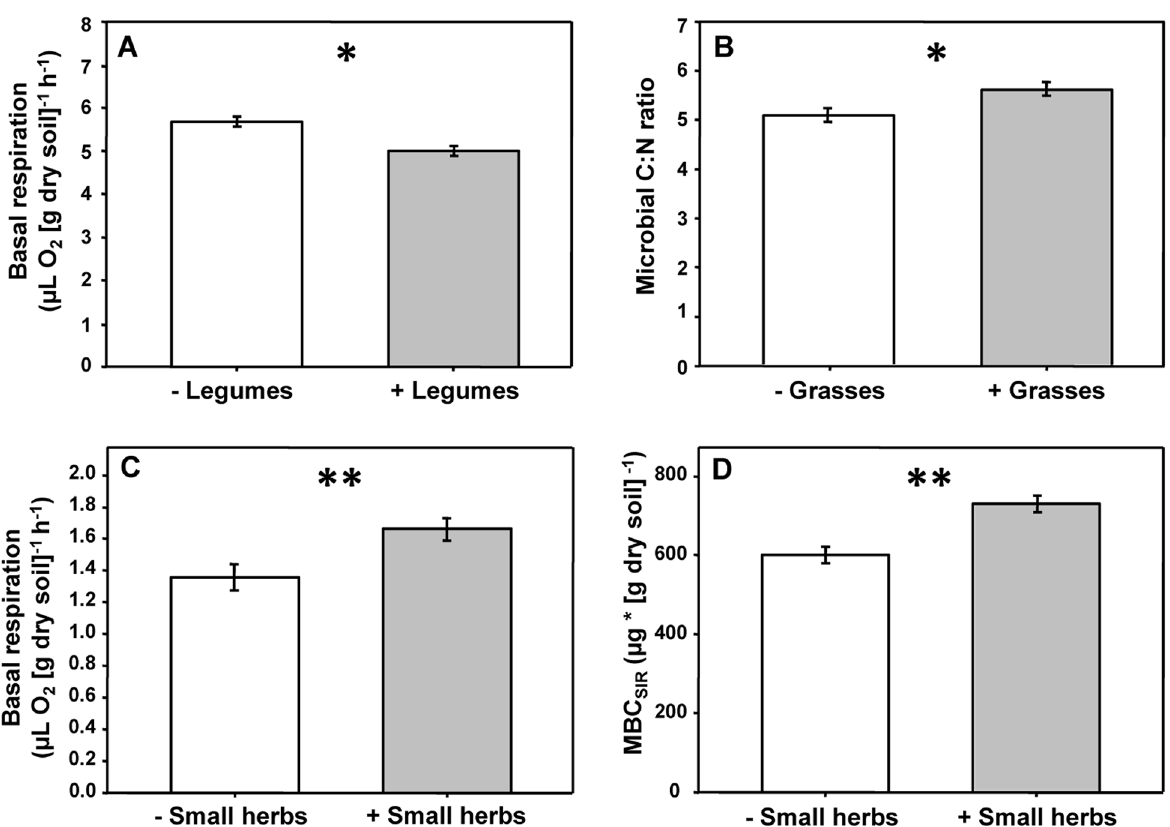
Fig 3. Effects of plant functional groups on microbial properties. Effects of (A) legumes and (B) grasses on microbial C-to-N (C:N) ratio. Effects of small herbs on (C) basal respiration and (D) soil microbial biomass C. Asterisks indicate significant differences ( * p (cid:1) 0.05, ** p (cid:1) 0.01). Means with standard error bars.